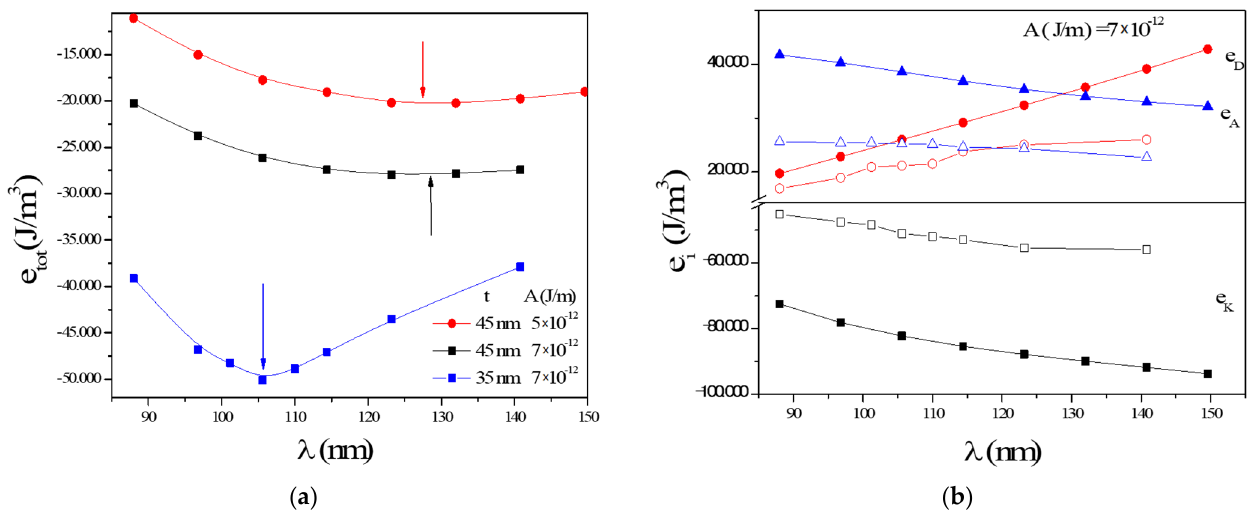
Figure 1. ( a ) Variation of the total energy density as a function of the stripe domain wavelength for a 45 nm thick (red and black) and 35 nm thick (blue) NdCo 5 ; ( b ) energy density contributions for 45 nm thick (full dots) and 35 nm thick (empty squares) NdCo 5 films. The exchange is kept constant for ( b ). No external magnetic field is